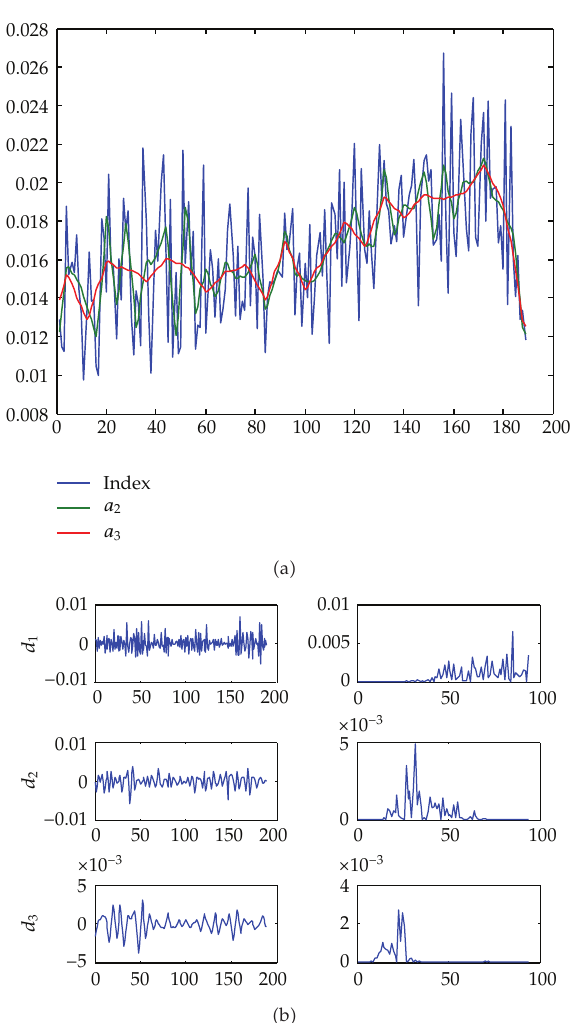
Figure 9: db3 filter, detail series, and FFT of SCTfe/Spain